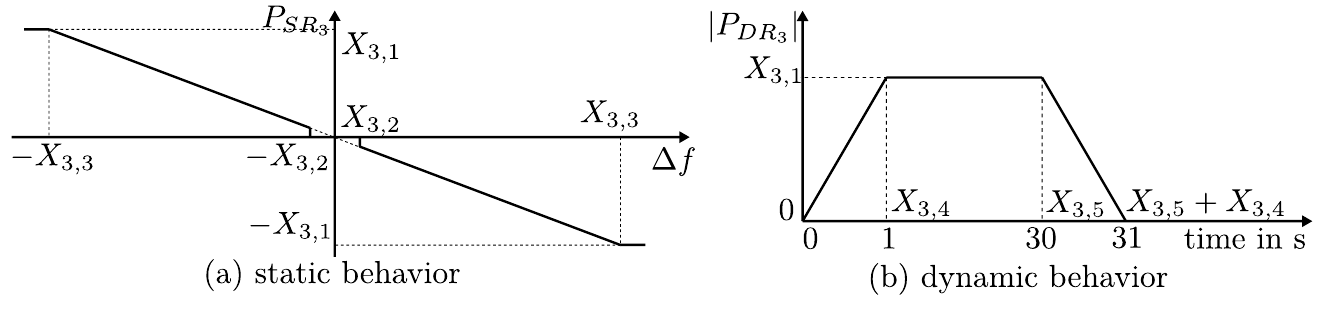
Figure A2. Static- and dynamic behavior of